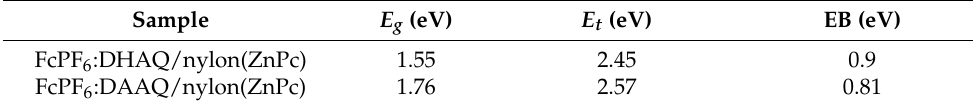
Table 3. Optical parameters for the organic